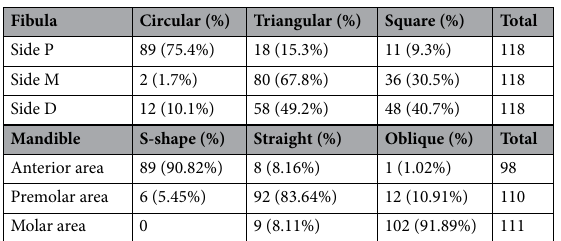
Table 2. The percentage of morphology of fibula and mandible at the selected cross-sections.